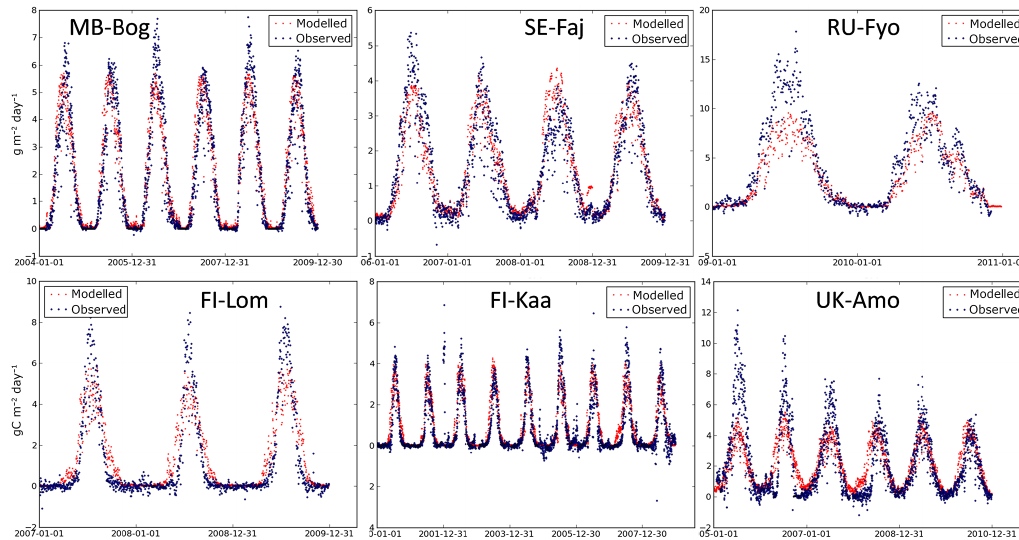
Figure 8. Simulated and observed daily GPP (gCm − 2 day − 1 ) in bogs and fens.